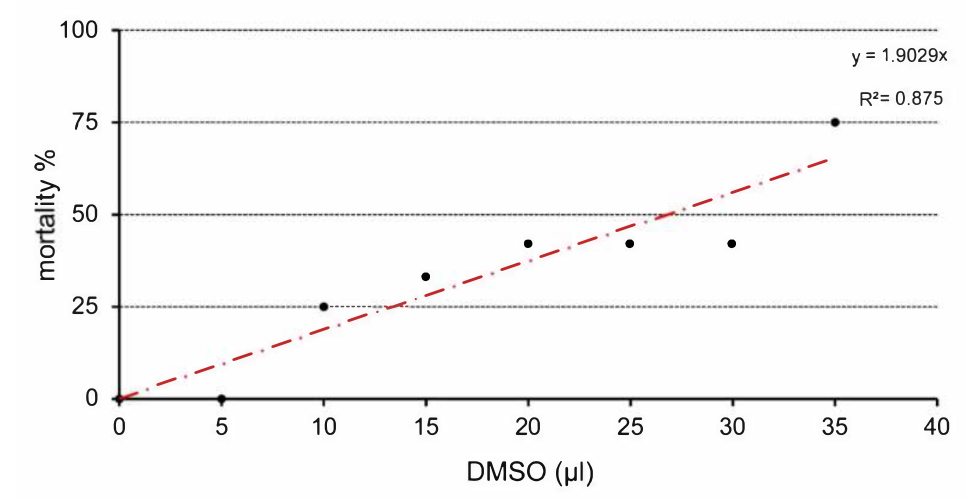
Figure 1. Relation between application dose of DMSO and mortality of chick